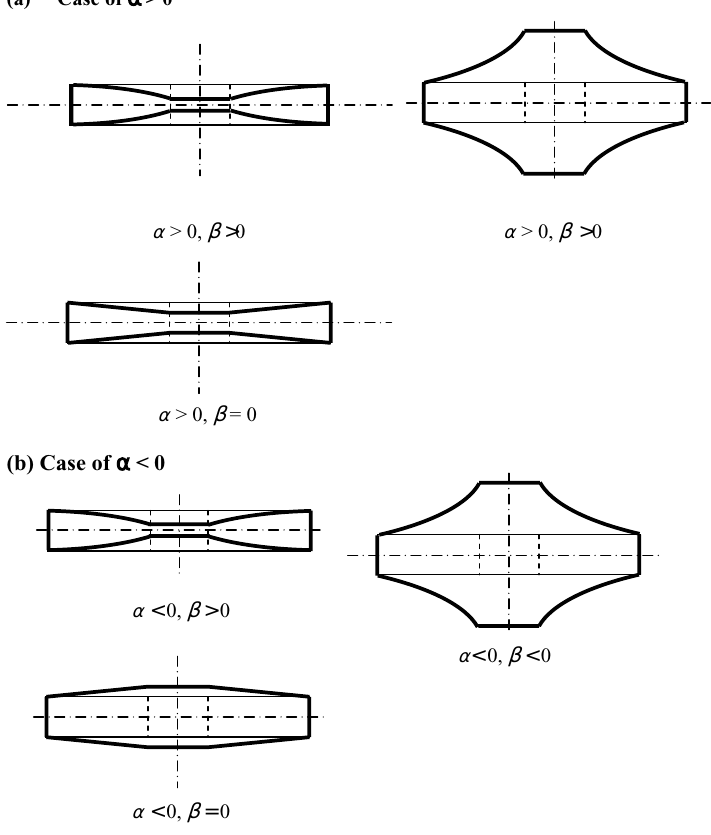
Fig. 2. Thickness variation under different combination of taper parameters α and β